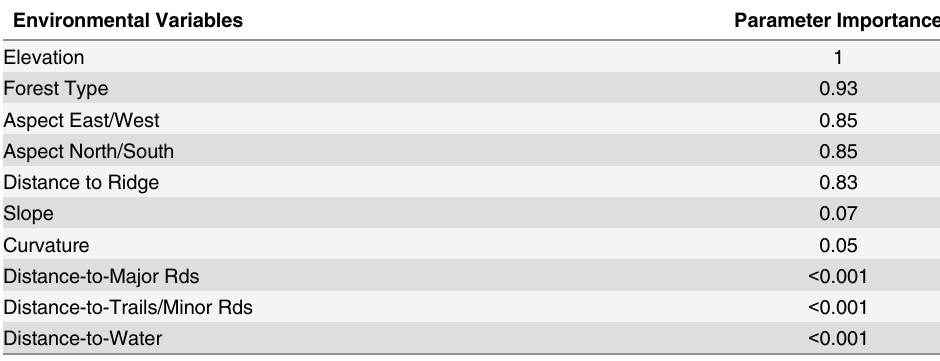
Table 4. Variable importance